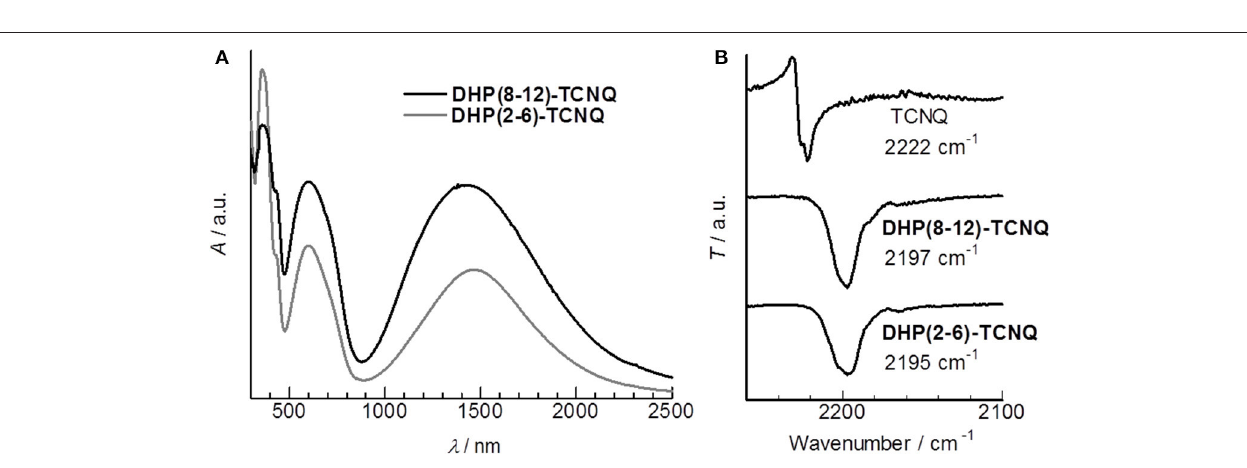
its C ≡ N stretching vibration ( ν C ≡ N ) (Chappell et al., 1981).